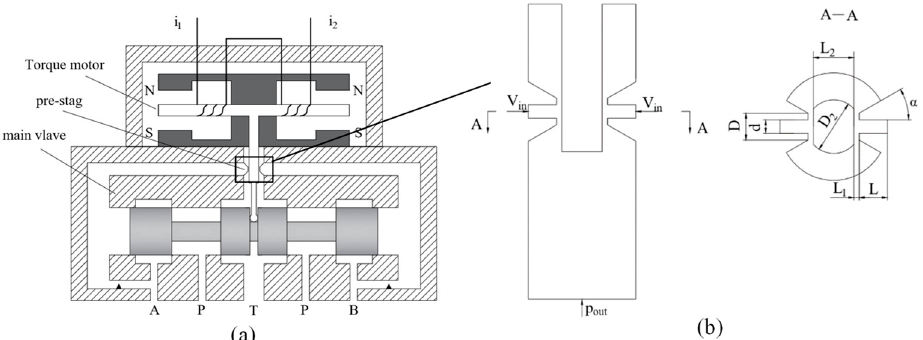
Figure 1. Principle diagram of jet flapper valve. ( a ) Structure schematic diagram of servo valve. ( b ) Pre-stage flow field and boundary conditions.